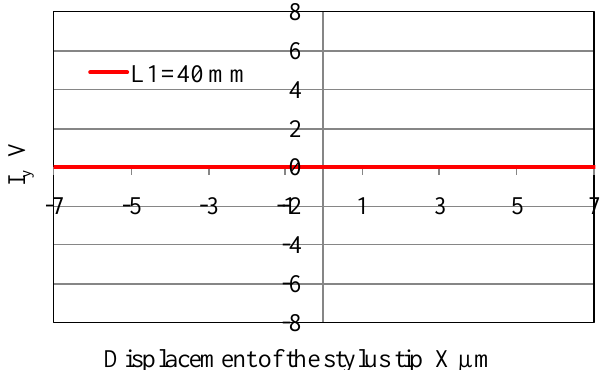
Fibers 2016 , 4 , 24